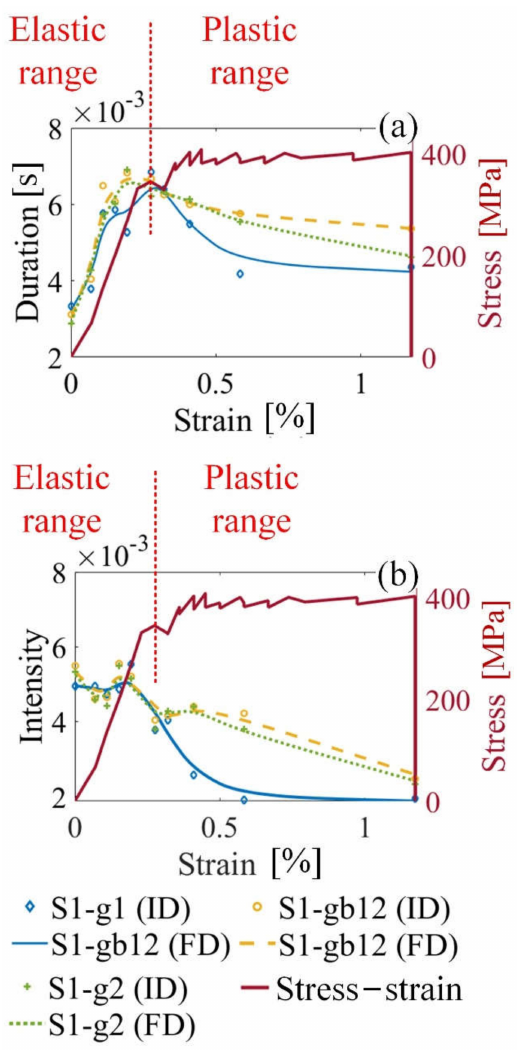
Figure 7. MBN transient eigenvalues ( T σ and INT σ ) on different locations under stress in elastic and plastic range of sample 1: ( a ) shows the duration T σ of sample 1; ( b ) shows the intensity INT σ of sample 1. FD denotes the fitting data, and ID denotes the original